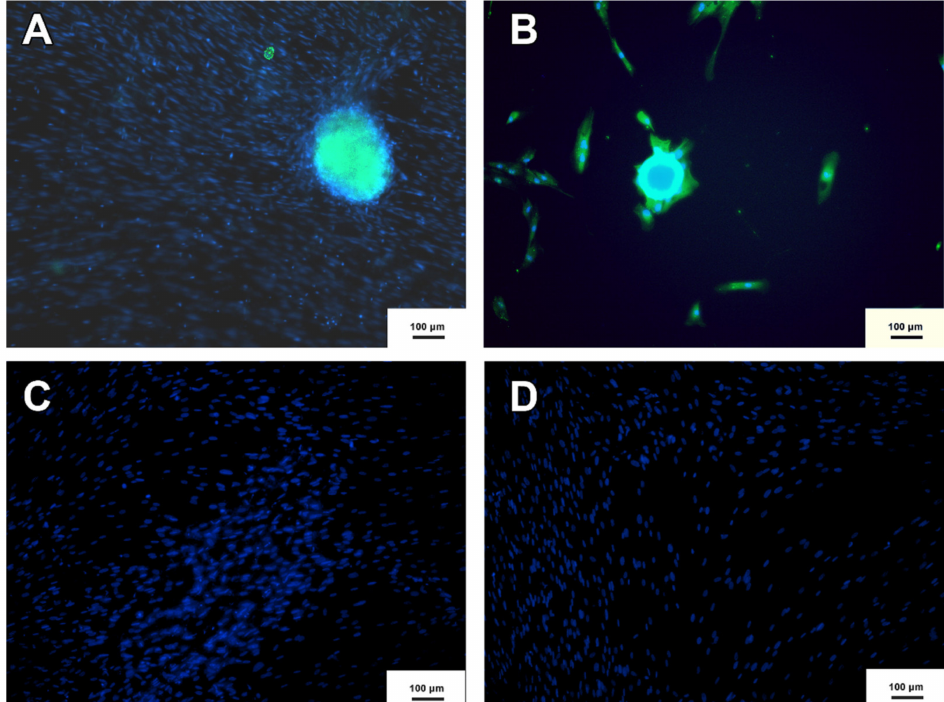
Figure 3. Neurosphere immunocytochemistry. ( A ) Neurosphere derived from MSC-WJ ( B ) Neuro- sphere derived from MSC-UCB. ( C , D ) represent the negative controls of both MSC-WJ and MSC-UCB respectively. This means that neither MSC-WJ nor MSC-UCB presented Nestin protein before being seeded in the NFBX. NESTIN protein is shown in green by FITC as a secondary antibody, and Hoechst was used for labeling the nuclei of the cells represented by blue (inverted fluorescence microscope × 100 (inverted fluorescence microscope Axio Vert A1, Carl Zeiss, Oberkochen,